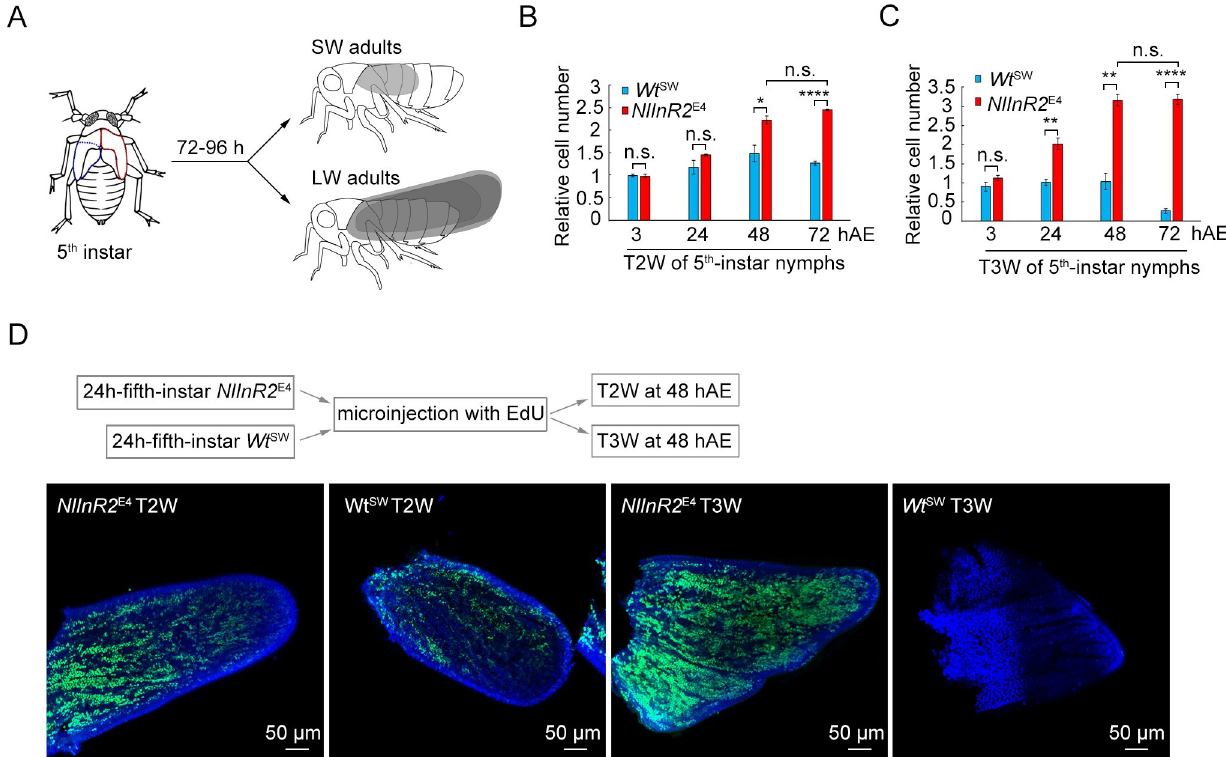
Fig 3. NlInR2 -null mutants increase wing cell number. (A) Schematic diagram of development of alternative wing morphs in BPHs. Fifth-instar nymphs can molt into short-winged (SW) or long-winged (LW) adults. Wing buds in the second thoracic segment (T2W) and third thoracic segment (T3W) indicated by red and blue dots, respectively. (B and C) Relative wing cell numbers in 5 th -instar NlInR2 E4 and Wt SW nymphs. T2W (B) and T3W (C) were dissected from 150 nymphs at 24-, 48, or 72 h after ecdysis (hAE), and genomic DNA was isolated for qRT-PCR analysis. Bars represent mean ± s.e.m. derived from three independent biological replicates. Statistical comparisons between two columns were performed using two-tailed Student’s t -test ( � , P < 0.05; �� , P < 0.01; ���� , P < 0.0001; n.s., no significance). (D) EdU staining of newly proliferated cells in wing buds during 24–48 hAE. Fifth-instar NlInR2 E4 and Wt SW nymphs at 24 hAE were microinjected with EdU, and T2W and T3W were dissected for Hoechst33342 (in blue) and EdU (in red) staining at 48